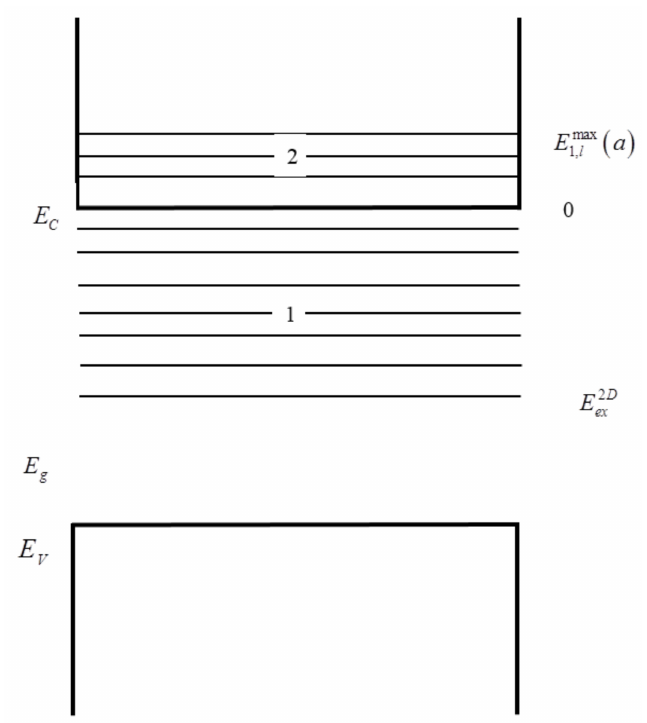
Figure 2. Schematic representation of the energy levels E 1, l ( a ) of the exciton (from spatially separated electron and hole) in the state ( n = 1 , l ≤ 8) in the nanosystem consisting of Al2O3 QD with a radius situated the dielectric matrix (vacuum oil). The stationary states of the exciton (area 1) are located in the bandgap of Al2O3 QD (below the bottom of the conduction band E s of Al2O3 QD). They are bounded below by level E 2 D ex , which is the binding energy of the ground state of the exciton (from spatially separated electrons and holes) in the nanosystems. Quasi-stationary states of the exciton (area 2) are in the E s conduction band of Al2O3 QD (above the bottom of the conduction band E s ). They are ( a ) (see Figure 1). In this limited to the top boundary of the spectrum of quasi-stationary states E max 1, l case, the hole moves in the valence band of QD, and the electron is located on energy levels (in area 1 and